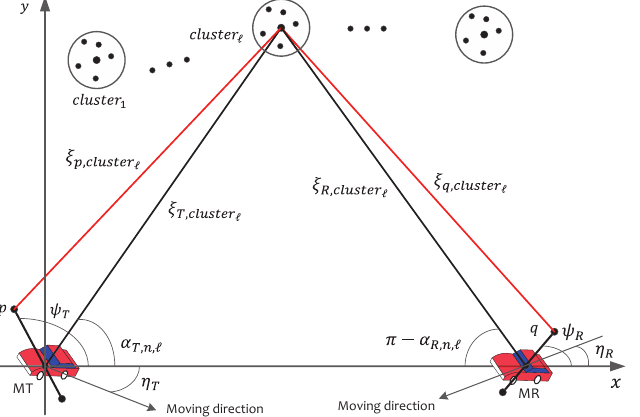
Figure 1. Angular parameters and path lengths of the WSSUS channel models for MIMO V2V